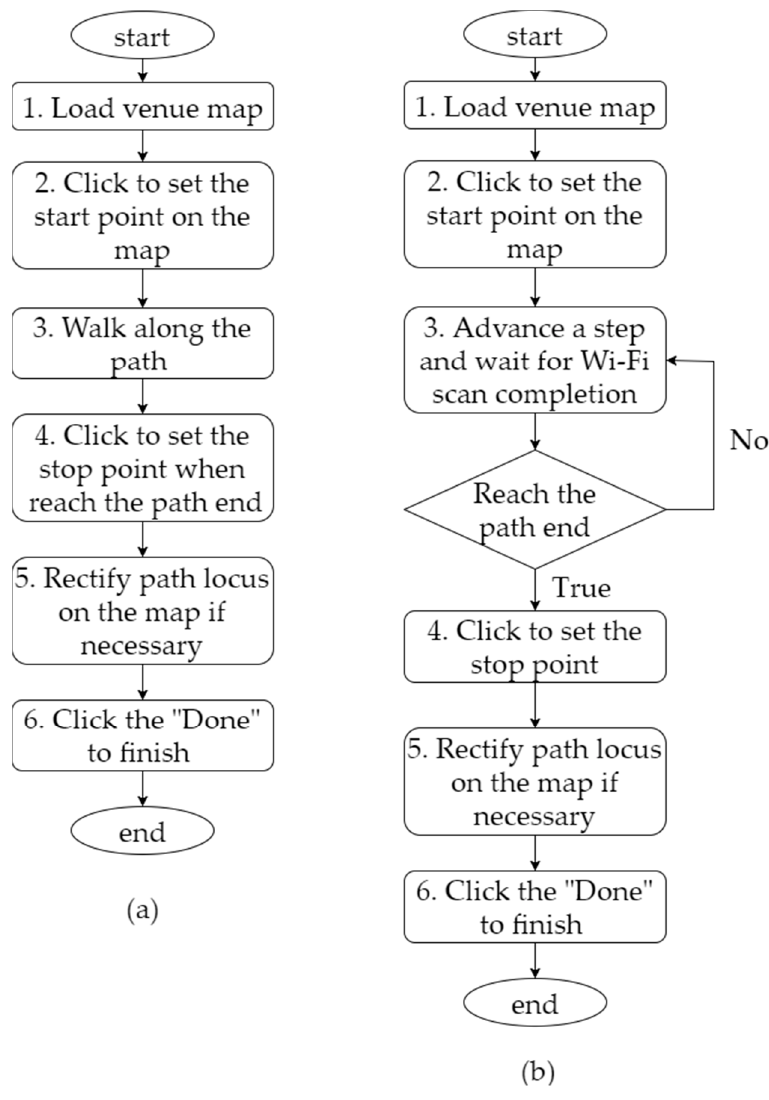
Figure 4. Wi-Fi signal procedures: ( a ) moving sampling (MS) and ( b ) stepped MS (SMS). Table 2. Amounts of time required to complete different sampling methods on a sampling route 54 m in length; SS: static sampling; MS: moving sampling; SMS: stepped MS.